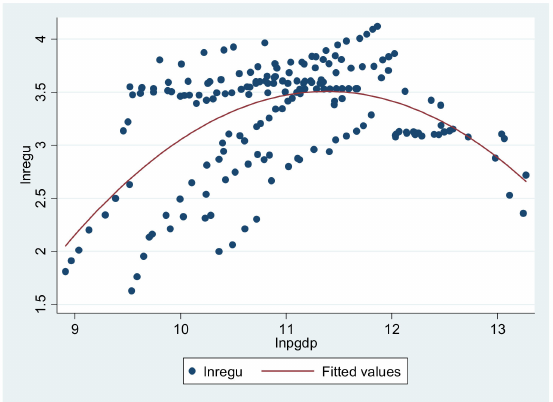
Figure 1. The relationship pattern between environmental regulation and economic